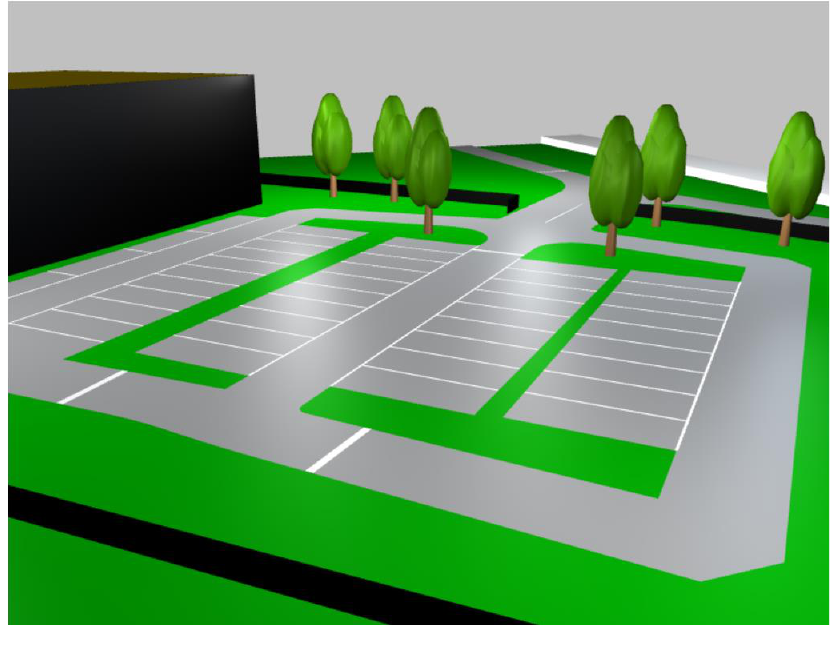
Figure 6. The 3D model animation. Infrastructures 2022 , 7 , 140